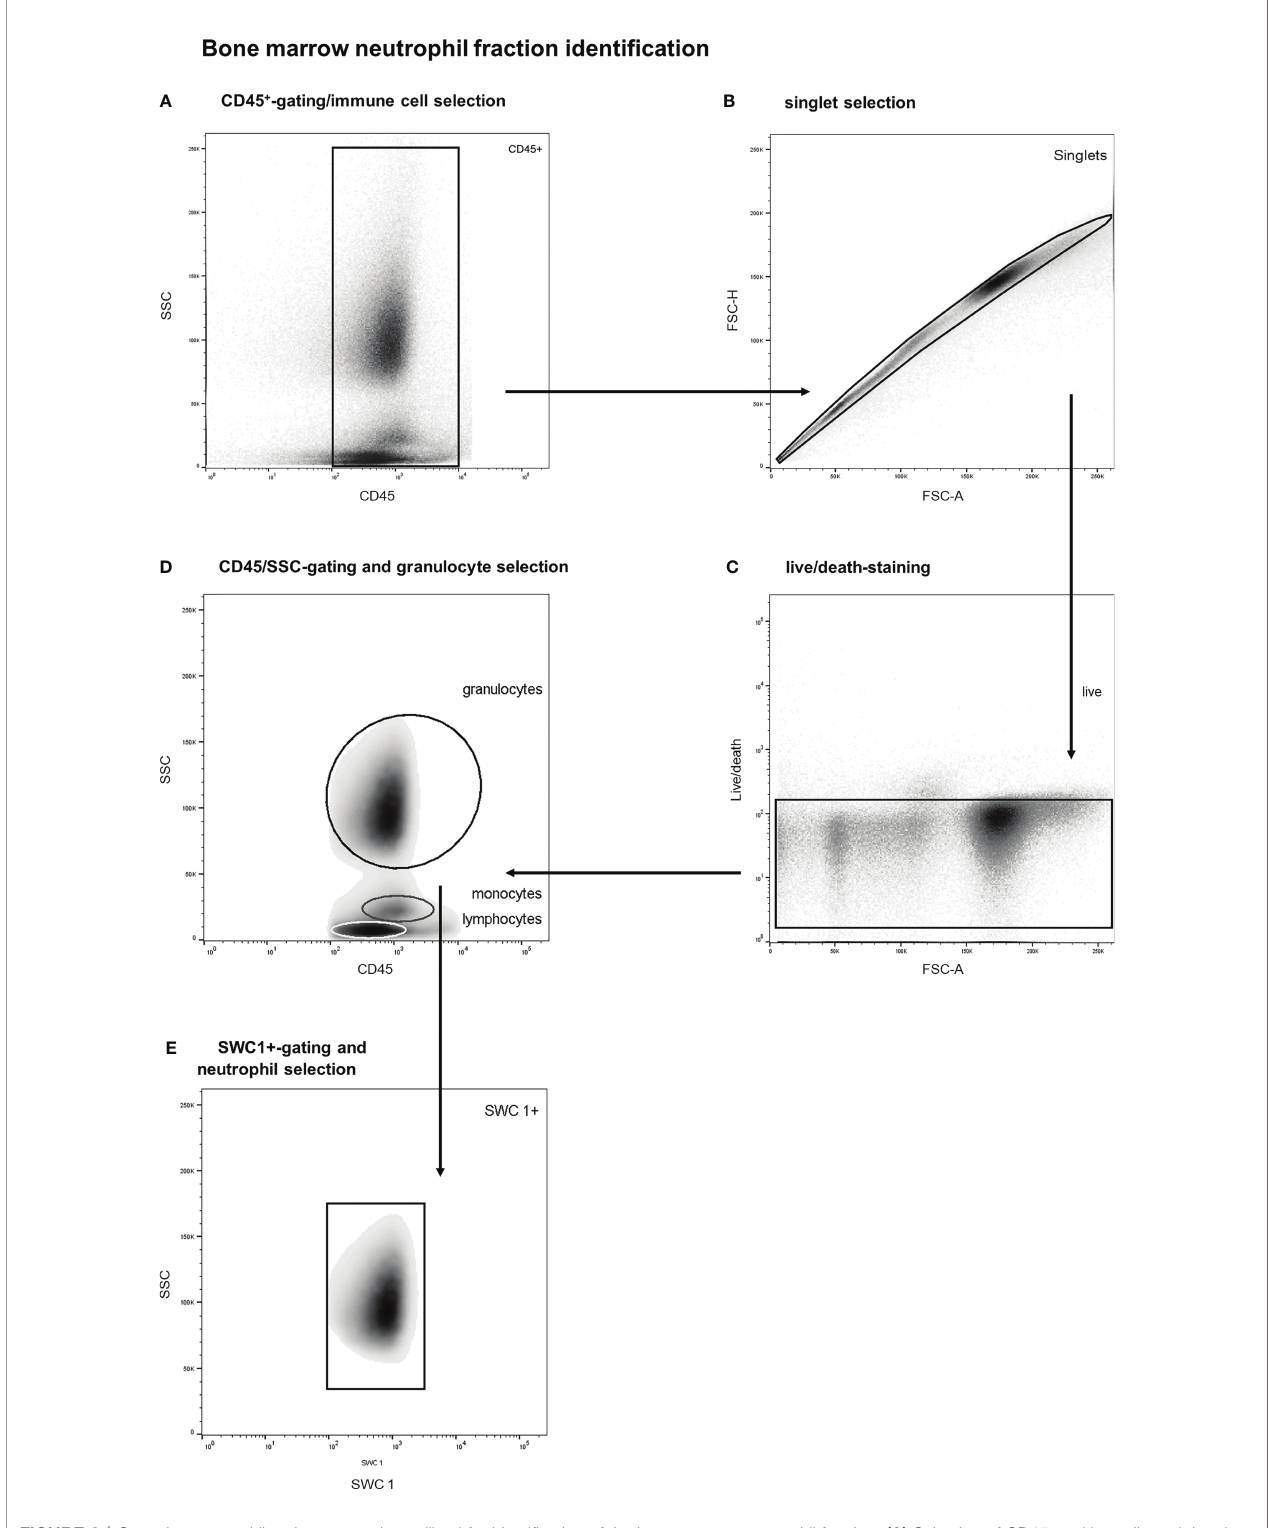
FIGURE 2 | Stepwise neutrophil gating protocol as utilized for identi fi cation of the bone marrow neutrophil fraction. (A) Selection of CD45 positive cells and thereby the exclusion of debris and non-immune cells. (B) Exclusion of doublets. (C) Life/death-stain and selection of viable immune cells. (D) Identi fi cation of different leukocyte subtypes and subsequent selection of granulocytes (of note: basophils are not included in the granulocyte gate due to distinct side scatter signal). (E) Selection of SWC 1+ cells, and thereby exclusion of potential contamination by eosinophils. SSC, sideward scatter signal; FSC, forward scatter